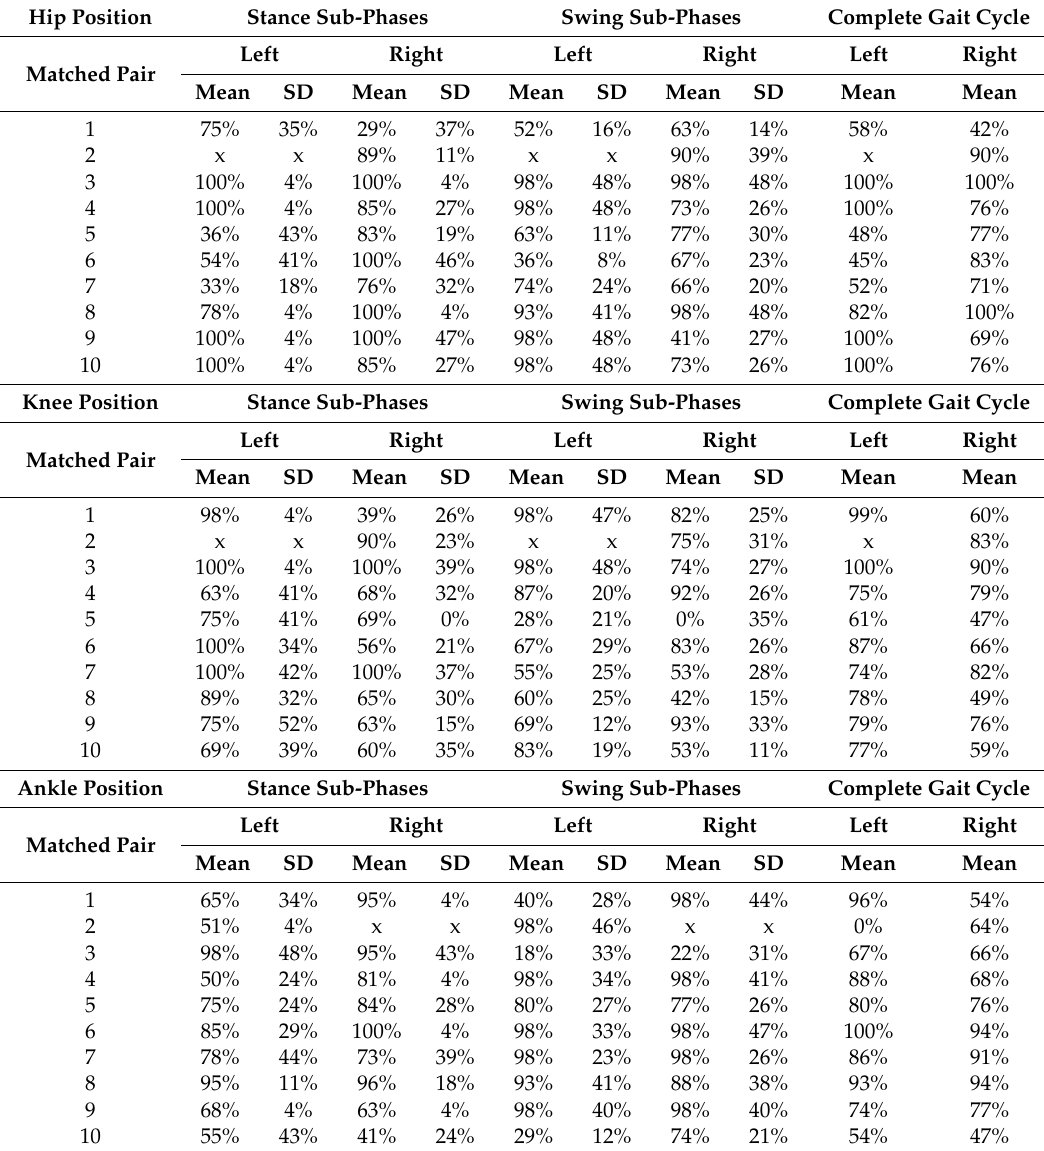
Table 1. Percentages of significant differences observed for hip, knee, and ankle position by Gait Phase, Limb and Matched Participant